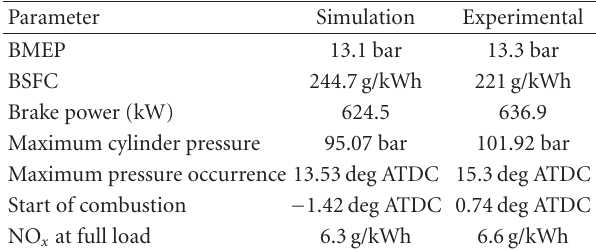
Table 3: Simulation and experimental